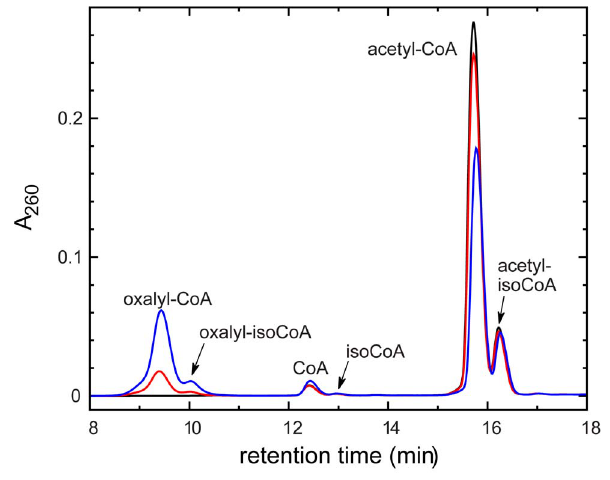
Figure 3. HPLC analysis of ACOCT reaction progress. HPLC traces showing time-dependent conversion of acetyl-CoA to oxalyl-CoA by UctC. IsoCoA is the 2 0 -phosphoryl isomer of CoA [49]. Black trace, t ~ 0 ; red trace, t ~ 1 min; blue trace, t ~ 10 min.